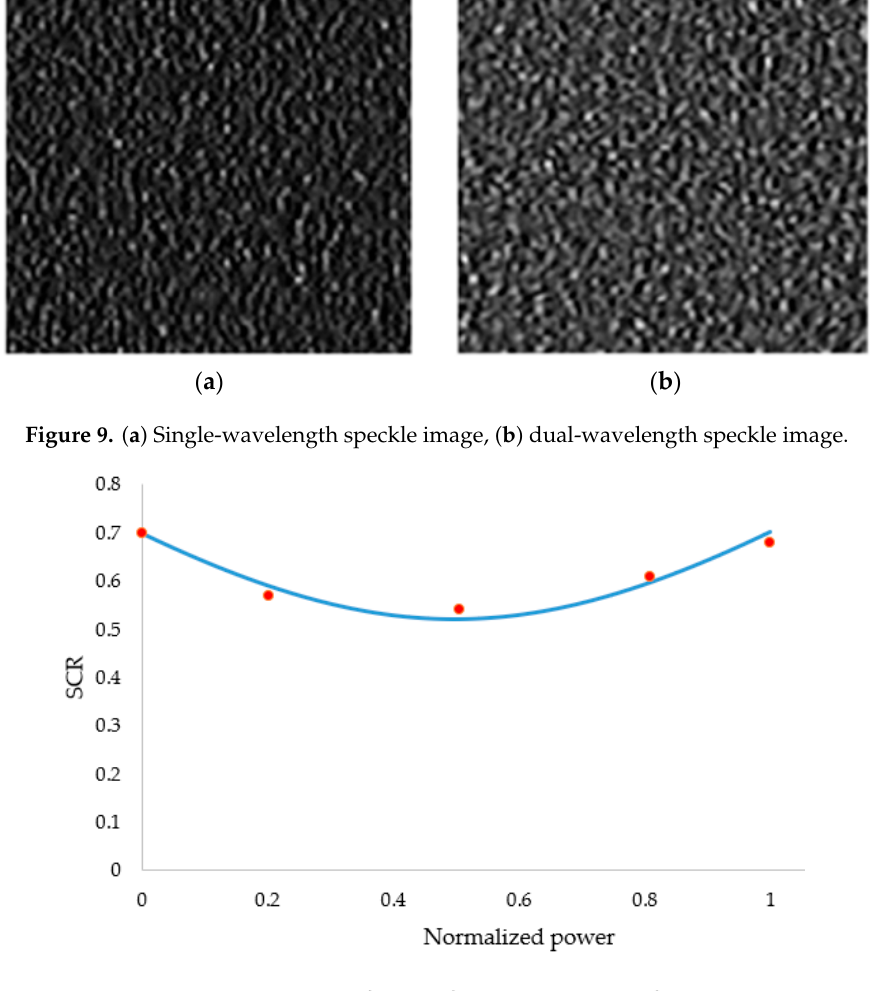
Figure 9. ( a ) Single-wavelength speckle image, ( b ) dual-wavelength speckle image.